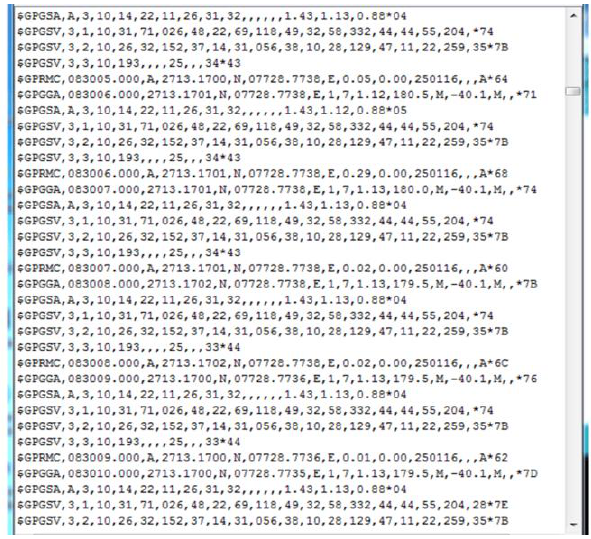
Figure 3 . Coordinate Raw Data.